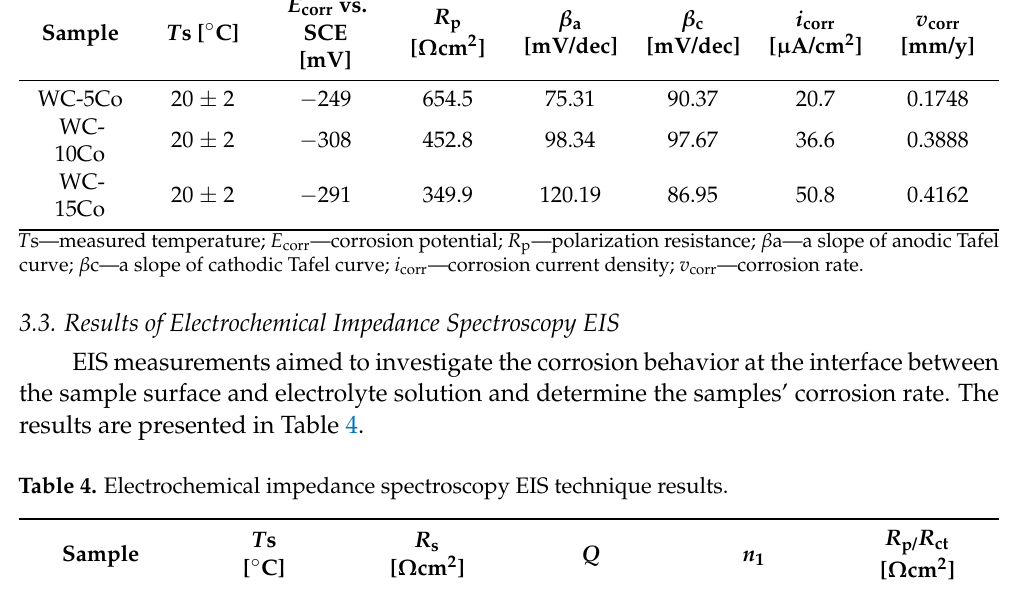
Table 3. Electrochemical DC techniques results.